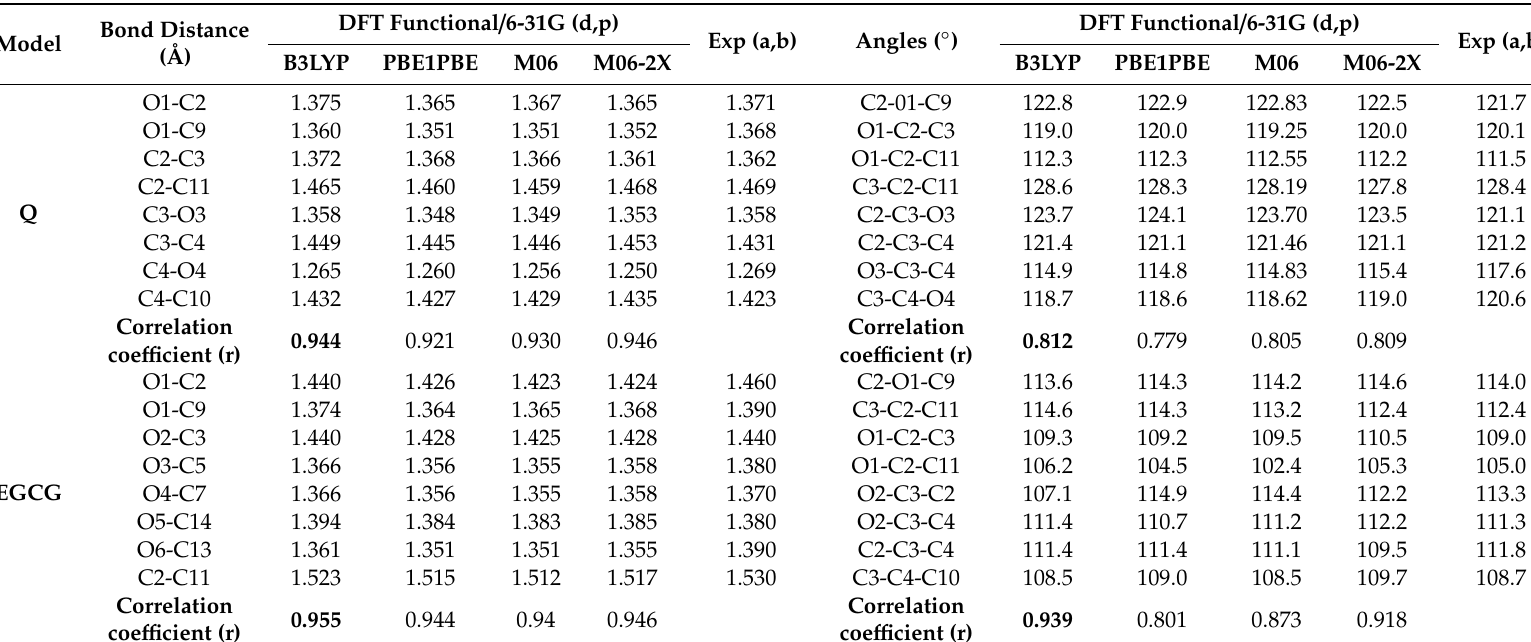
Table 1. Q and EGCG geometrical parameters calculated in the solvent phase (water) using IEFPCM solvation model, and the X-ray di ff raction data reported for the same